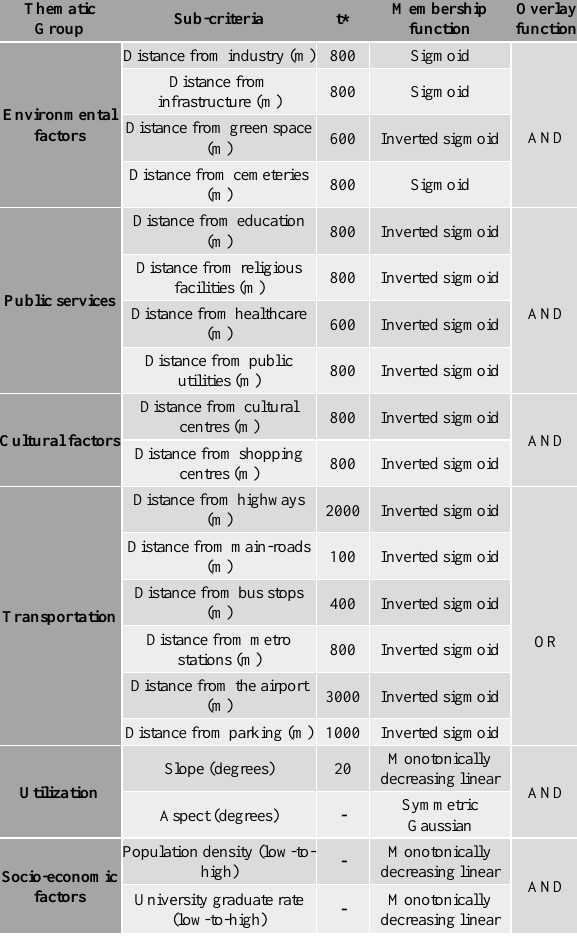
Table 1. The valuation criteria with fuzzy membership